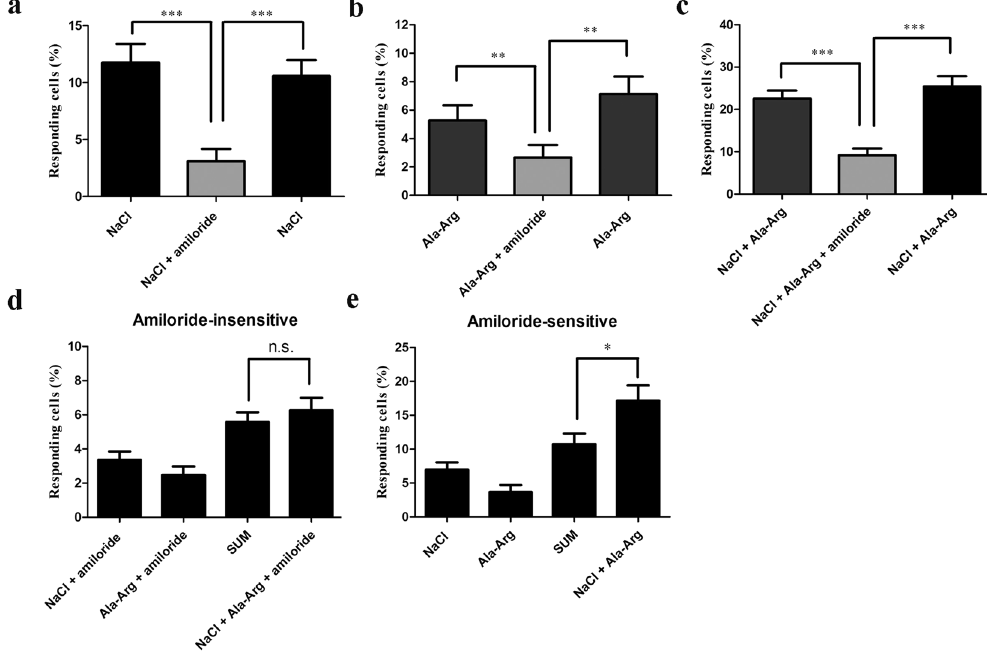
Figure 4. Signaling pathway utilized by Ala-Arg (AR). (a – c) Amiloride (50 μ M) significantly suppressed responses induced by NaCl (a) , AR (b) , and the mixture of NaCl and AR (c) . HBO cells were stimulated with three stimuli; the third stimulus was the same as the first one to demonstrate that cells were the responsive equally first stimulus. Each experiment was performed six times. (d and e) AR (50 μ M) increased the percent cell responses to 150 mM NaCl via the amiloride-sensitive but not the amiloride-insensitive pathway. Each experiment was performed nineteen times. The concentration of amiloride was 50 μ M. The percentage of responding cells was determined by intracellular Ca 2 + changes. * p < 0.05, ** p < 0.01, *** p < 0.001, n.s., not